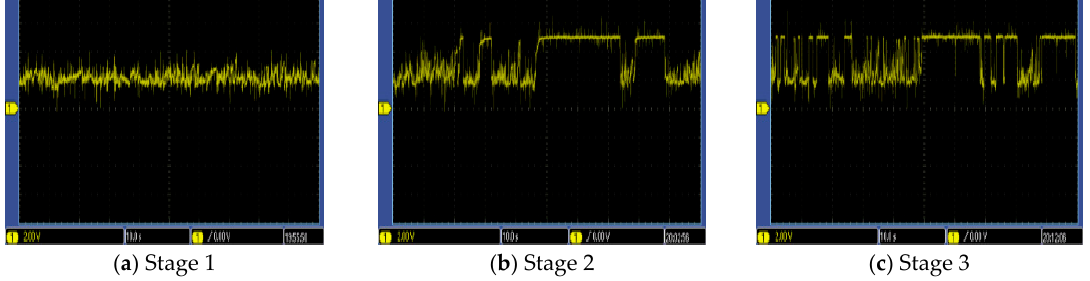
Figure 4. The curve of contact resistance under different states of the electrical connector.